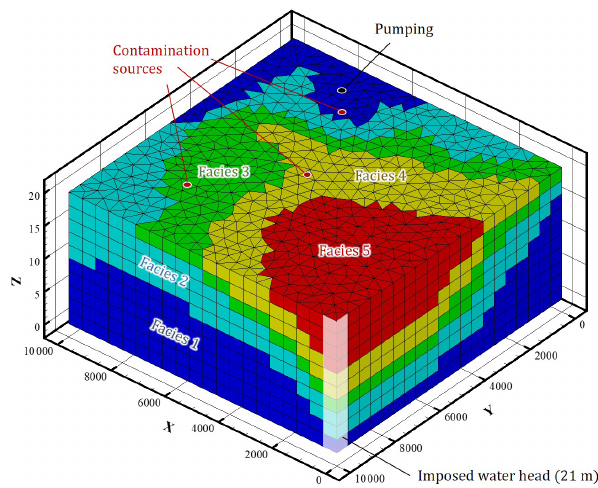
Figure 2. Three-dimensional facies distribution of the synthetic aquifer and aquifer discretization – the black dot is the location of the pumping well and the red dots the location of the contaminant